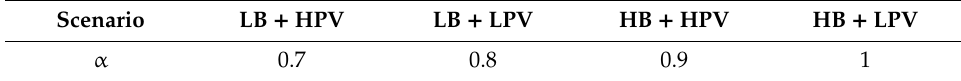
Table 4. Battery lifetime degradation factor α